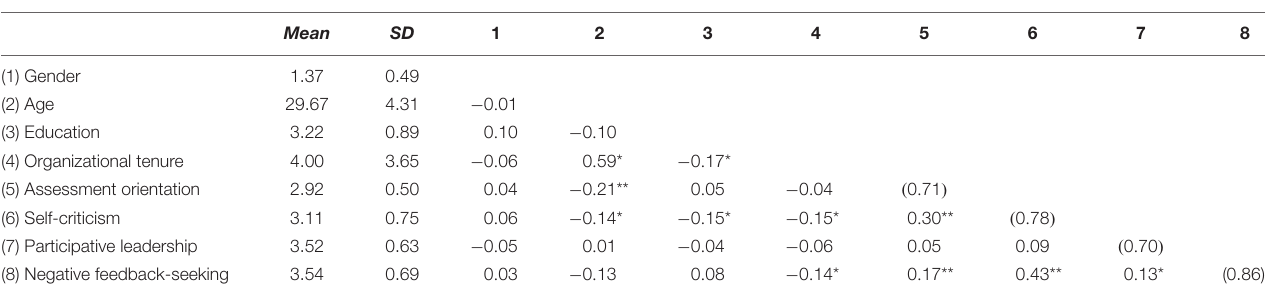
TABLE 2 | Means, standard deviations, correlations, and alphas of